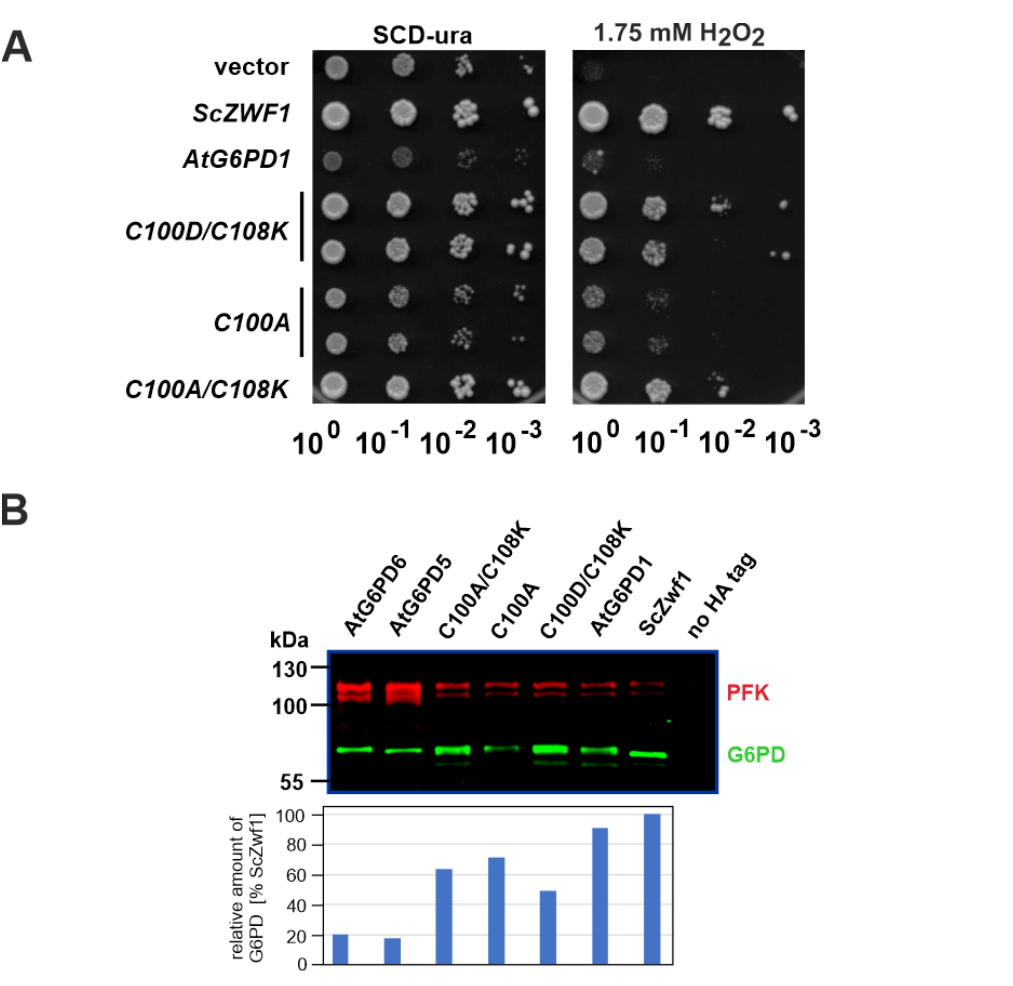
Figure 4. Analysis of a yeast zwf1 deletion producing different G6PD isoforms from Arabidopsis thaliana . A ) Logarithmically growing cultures of strain HOD269-1C ( zwf1::kanMX ) carrying either the wild-type AtG6PD1 gene or the mutated variants indicated on a CEN/ARS vector were subjected to drop dilution assays and analyzed as explained in the legend of Figure 2. Strains carrying the empty vector or a plasmid with the native ScZWF1 gene were employed as controls. B ) Western blot of crude extracts from strains producing the indicated AtG6PD isoforms. Antisera and quantification were as explained in the legend of Figure 1C, setting the amount of ScZwf1 to 100%. C ) Sensitivity of different G6PD enzymes produced in the yeast zwf1 deletion strain towards reductive (DTT) and oxidative (diamide) conditions. Specific enzyme activities were either directly determined after preparation of crude extracts (yellow columns) or after pre-treatment of the same crude extracts with 1 mM DTT